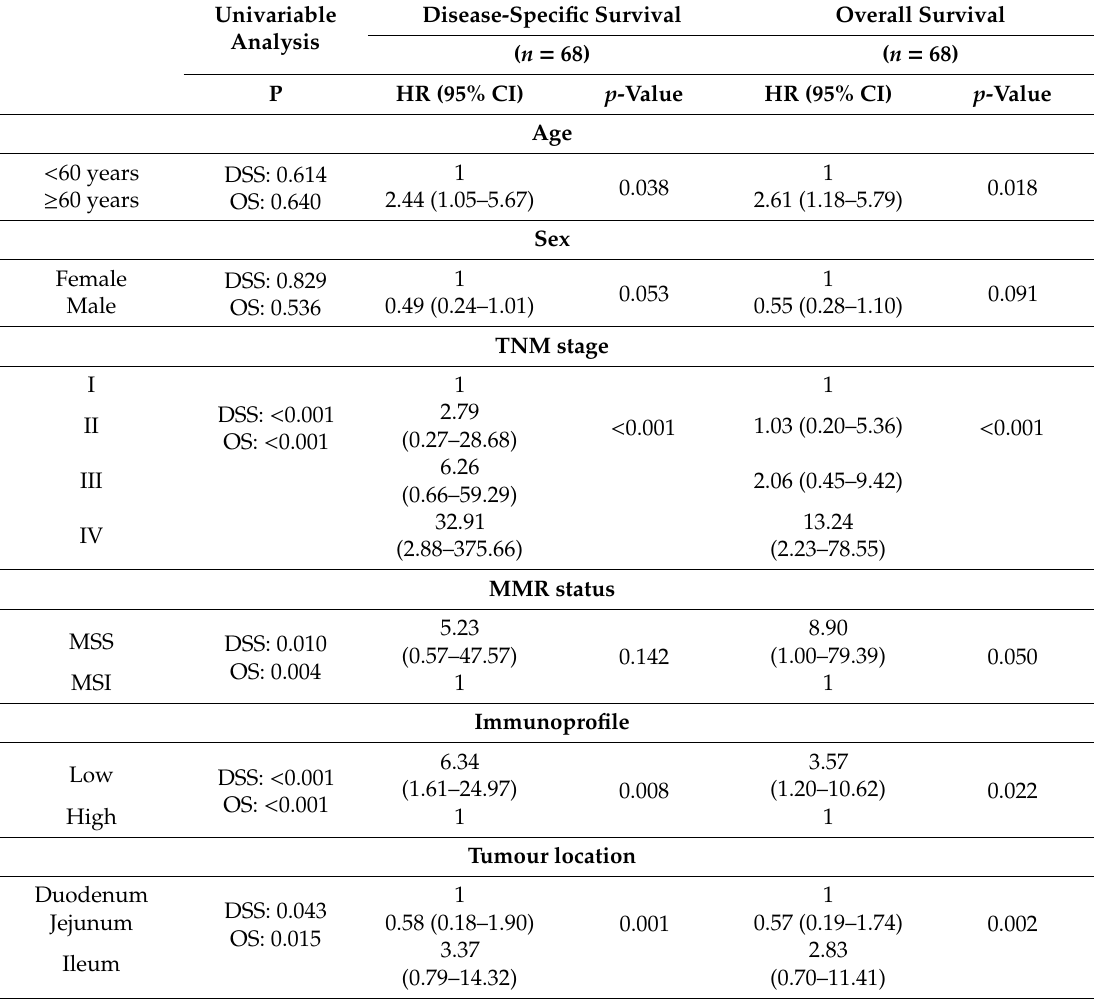
Table 5. Multivariable analysis with